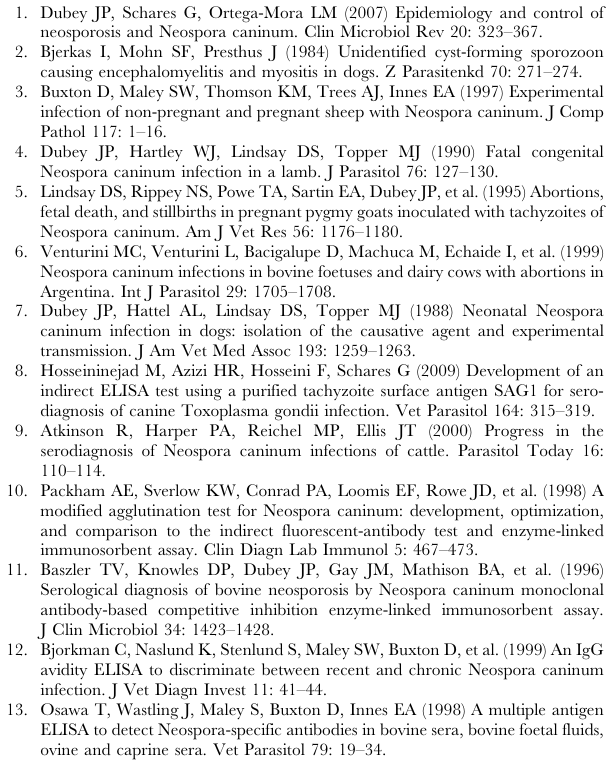
Figure S3 Inhibition of A10 and H3 antibody binding to rNcSAG1 with anti- N. caninum antibodies in neosporosis-positive serum. Sera samples from healthy cattle (negative) and N. caninum - infected cattle (positive), which were different from those used in Figure 6, were provided by Tobu Livestock Disease Diagnostic Center of Japan. These sera were used to inhibit the binding of A10 or H3 to immobilized rNcSAG1on a microplate (n= 3). Figure S4 Molecular model of the variable regions of antibodies A10 and H3. Structures were built using WAM antibody modeling server. A10 is shown in green, and the blue parts stand for the A10-CDRH3 and A10-CDRL3; H3 is in red, and dark red parts stand for the H3-CDRH3 and H3-CDRL3.